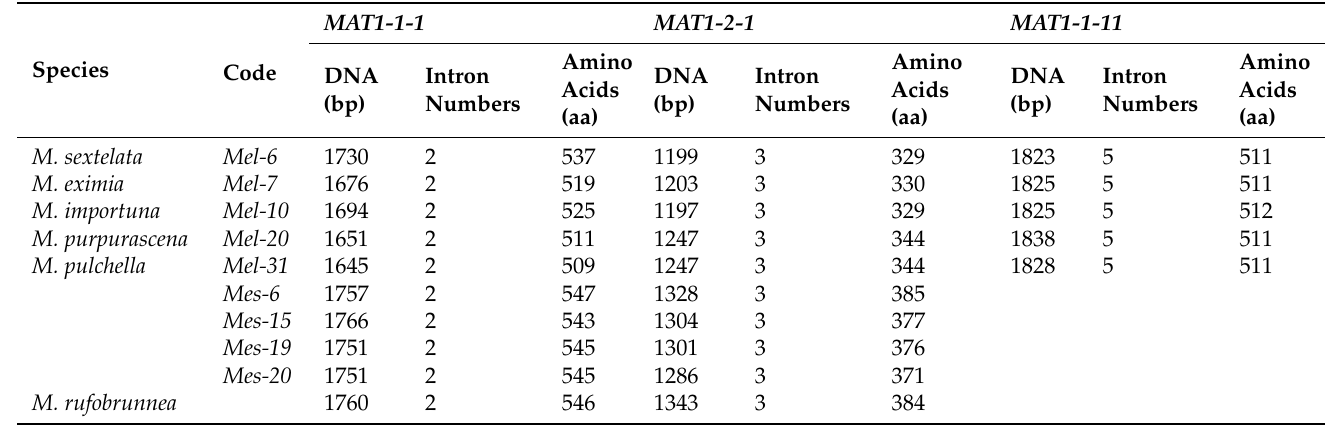
Table 3. The variance of the mating genes in ten morel